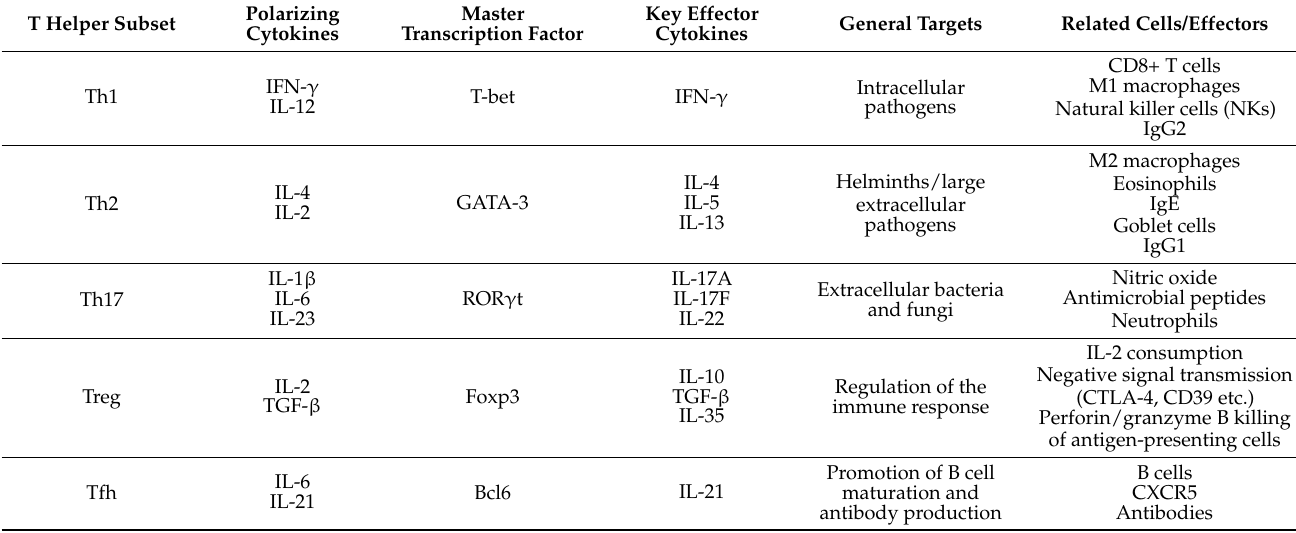
Table 3. Characteristics of T helper (CD4+ T) cell subtypes and their associated immune responses